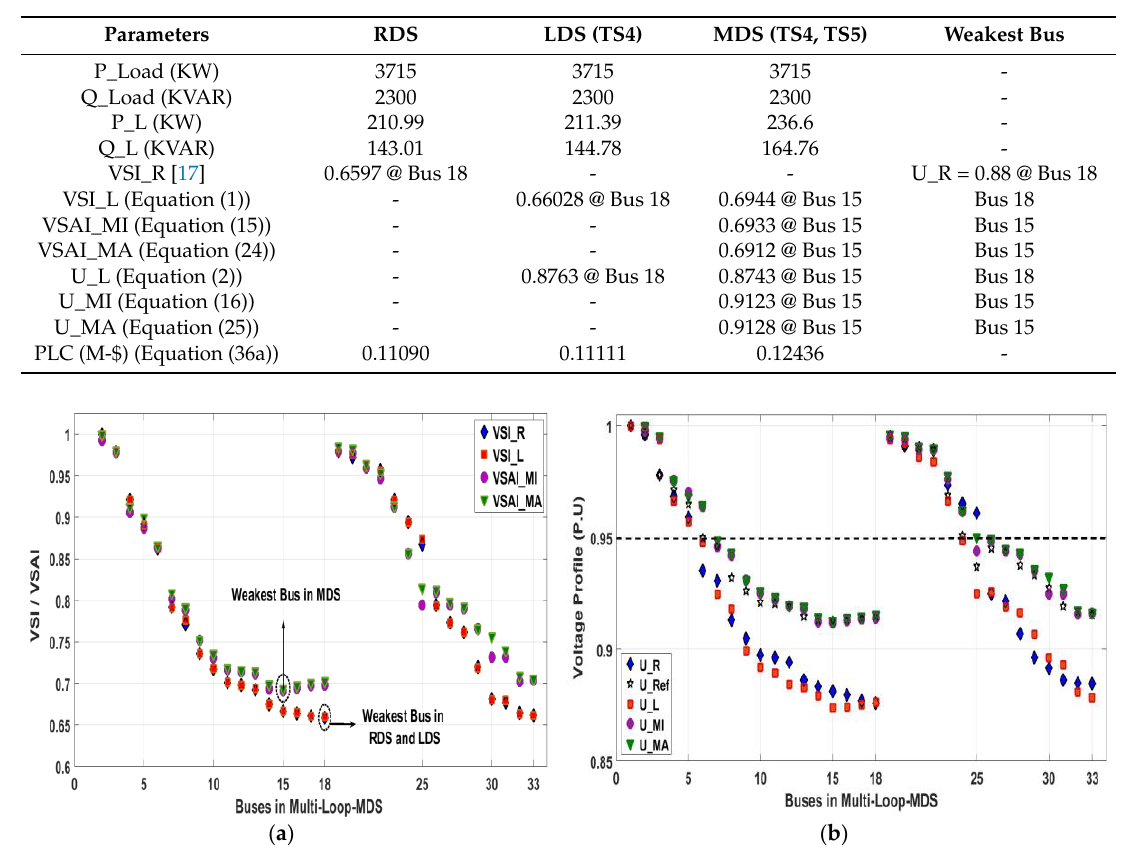
Figure 6. The base case with no DG (Steps 1 – 4) ( a ) Different voltage based indices with no DG in 33-Bus distribution network; ( b ) Voltage profile with no DG in 33-Bus distribution network.